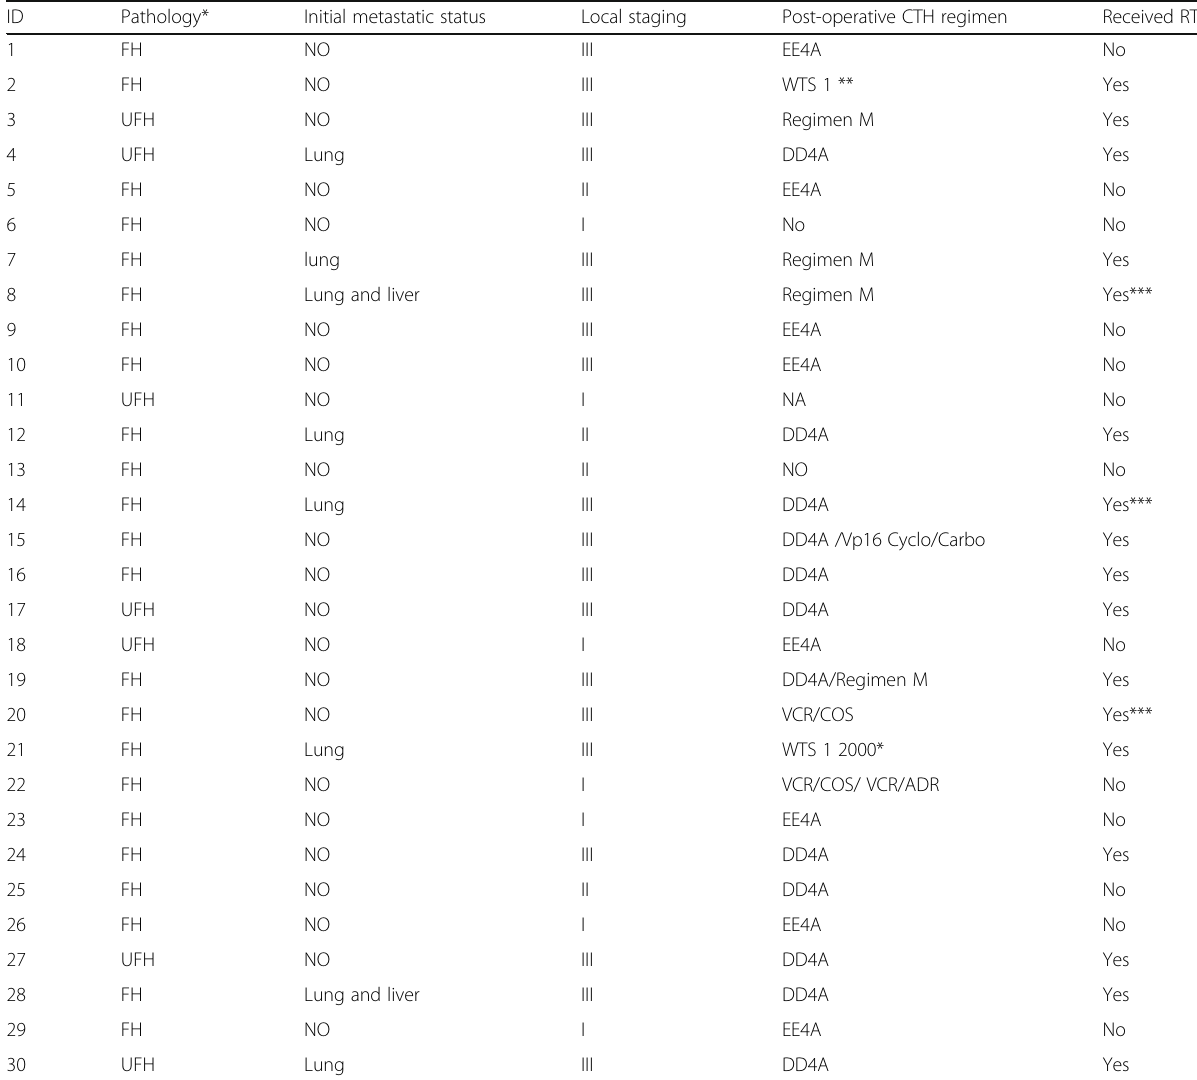
Table 1 Initial management of the entire study